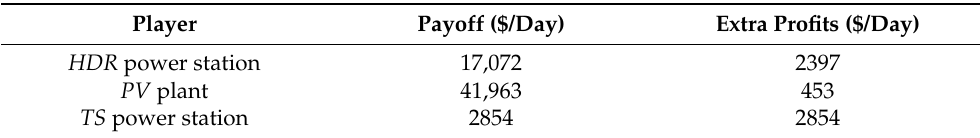
Table 4. Allocation based on Shapley